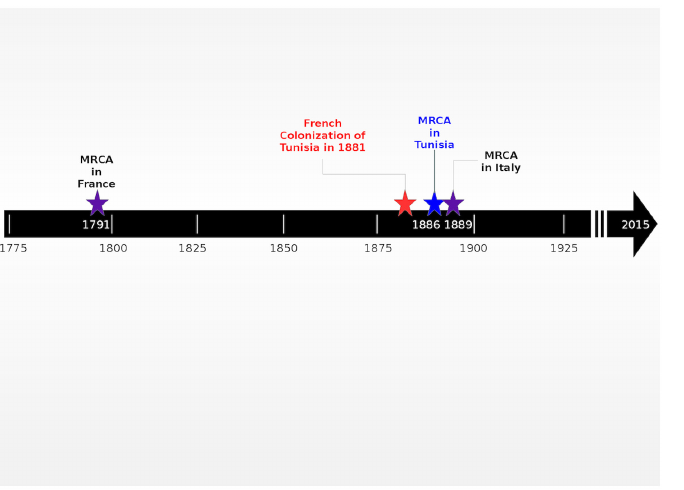
Fig 4. The timeline of HCV subtype 2c introduction in